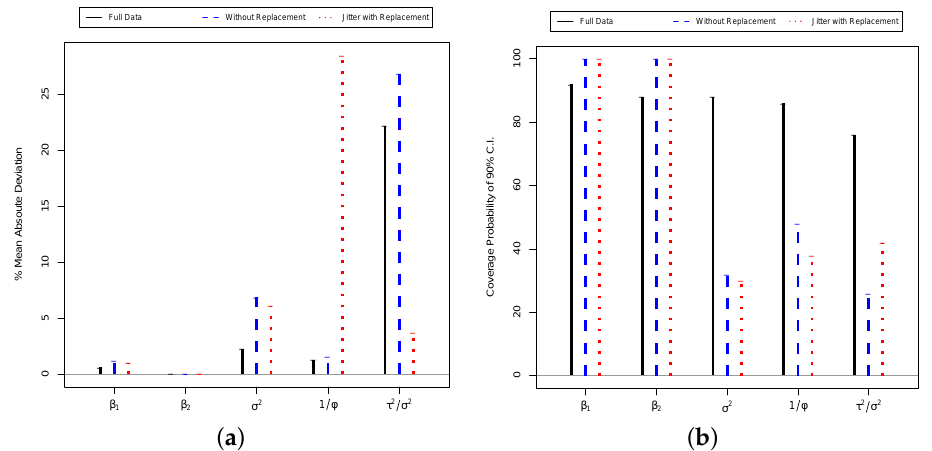
Figure A1. Results from Monte Carlo Experiment of Performance over an N = 2000 Dataset versus Bootstrap Methods. ( a ) % Mean Absolute Deviation, ( b ) Coverage